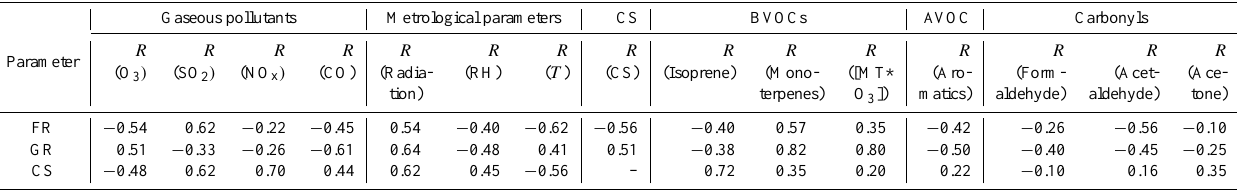
Table 3. Linear correlations of gaseous pollutants, metrological parameters, CS, BVOCs, AVOCs and carbonyls with the FR, GR and CS for all NPF events observed during the sampling campaign. The data points for gaseous pollutants, metrological parameters and CS are 72; for VOCs and carbonyls are 32. The p-values for all the correlations are below 0.05.